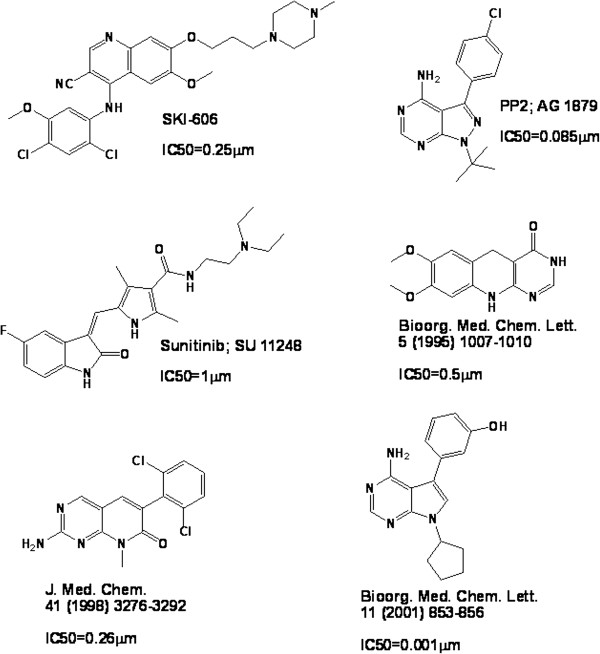
The structures of representative c-Src inhibitors.